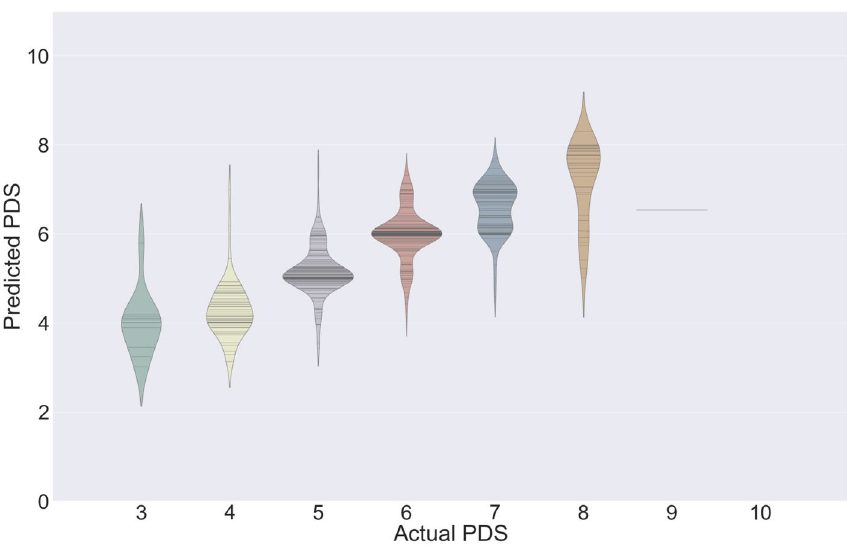
Figure 1. Predicted Pederson difficulty score (PDS) distribution of the actual PDS. The distribution of predicted PDS was generally close to the actual PDS. Whereas it performed well for PDS 4–7, it overestimated the cases of PDS 3 and underestimated the cases of PDS 8 and